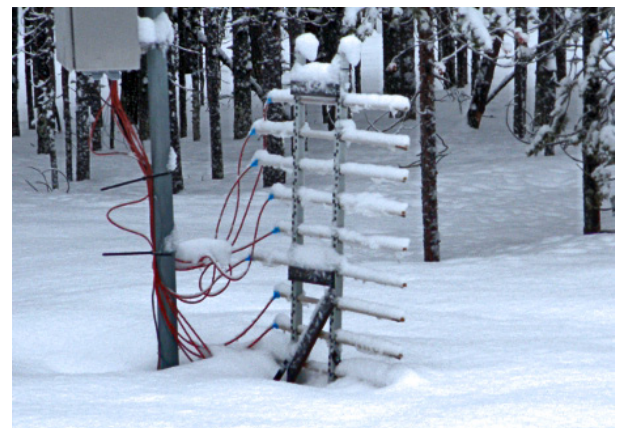
Figure 4. Snow temperature was measured with an array of hor- izontally oriented temperature sensors at the meteorological mast. Image modified after Lemmetyinen et al.